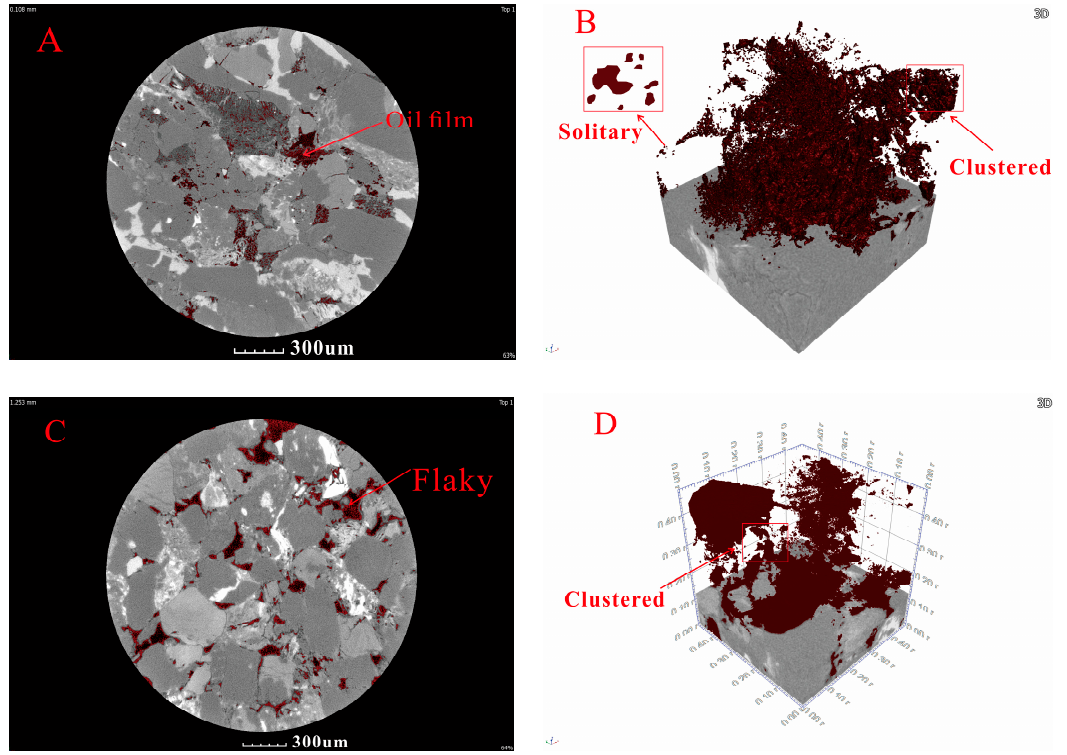
Figure 4. ( A ) Residual oil in 2D sections (Sample No. 1); ( B ) 3D of residual oil distribution (Sample No. 1); ( C ) Residual oil in 2D sections (Sample No. 8); ( D ) 3D of residual oil distribution (Sample